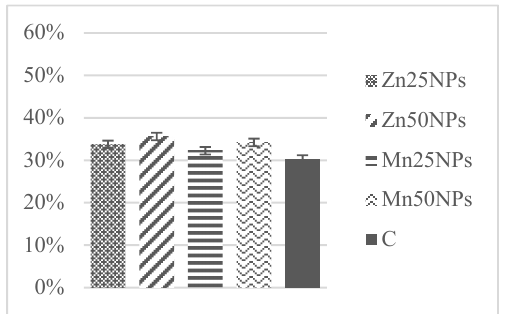
Figure 7. Percentage of turkey sperm producing NO (%) in samples stored for 2 h with or without